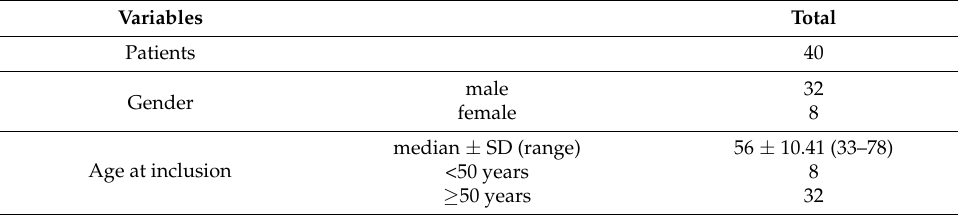
Table 1. Clinicopathological characteristics of the